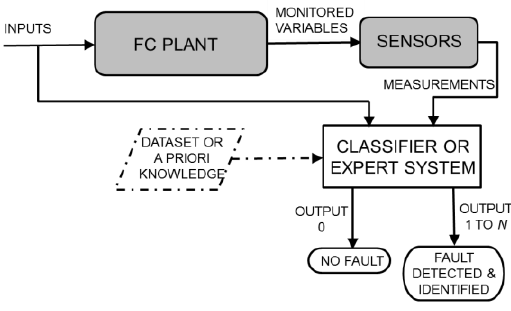
Figure 2. Schematic of the data-driven FDI strategy applied to FC plants.